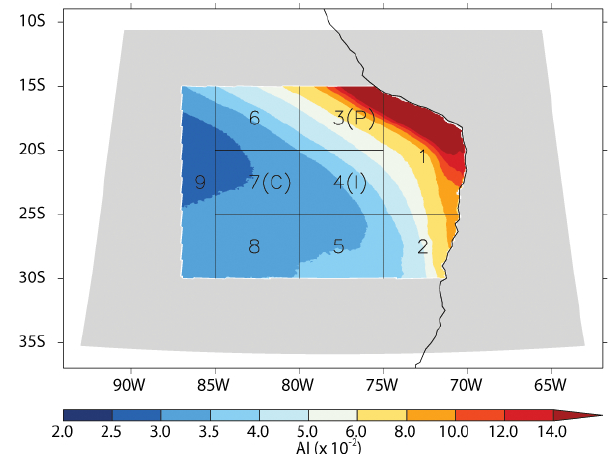
Fig. 1. Monthly average aerosol indexes (AI) during the VOCALS- REx period. The modeling domain is divided into 9 regions (num- bered by 1–9) with the regions 3–8 being 5° × 5° in sizes. Regions 3, 4, and 7 are also referred as polluted (P), intermediate (I), and clean (C) regions in the main text. The grey area shows the model domain. Areas too close to the lateral boundaries are not included in this